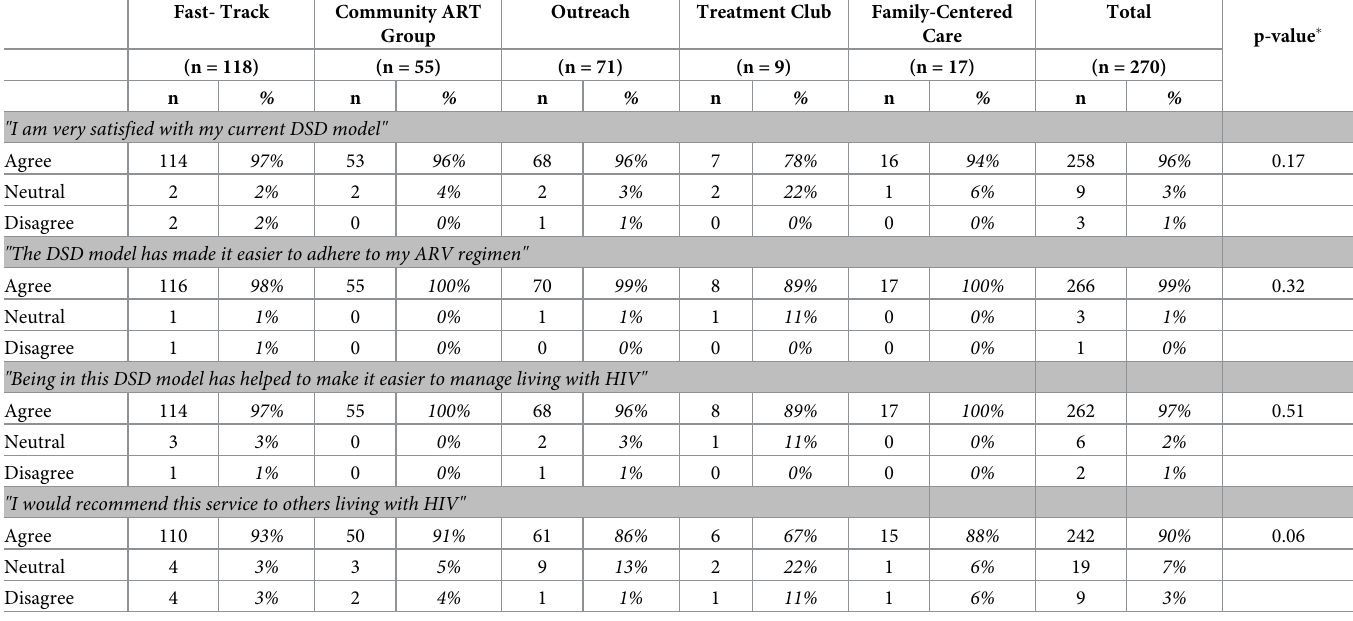
Table 2. Client satisfaction by model. Fast-